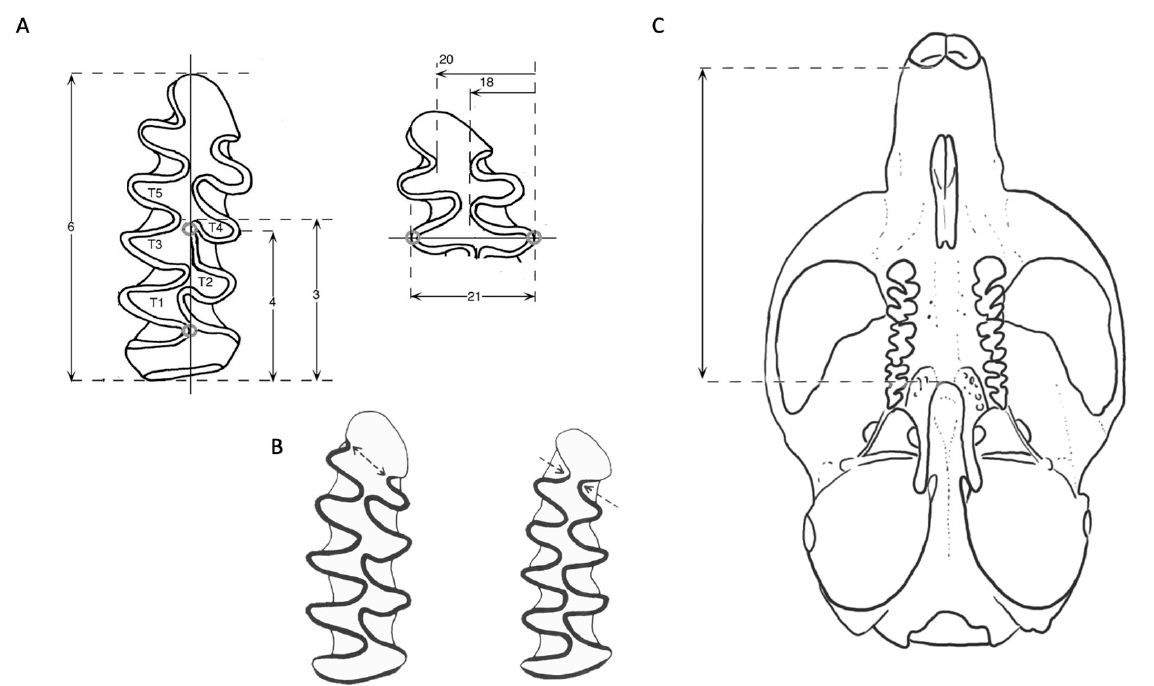
Figure 3. ( A ) Measurements taken on the occlusal surface of the first lower molar in the studied specimens. ( B ) First lower molars of Microtus ( Terricola ) with open ( left ) and closed ( right ) anterior loops. ( C ) Measurement of the palatilar length in Microtus ( Terricola ) skull (redrawn from [6]).